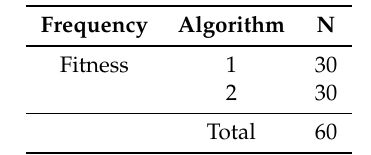
Table 4. Two sample Kolmogorov–Smirnov test.